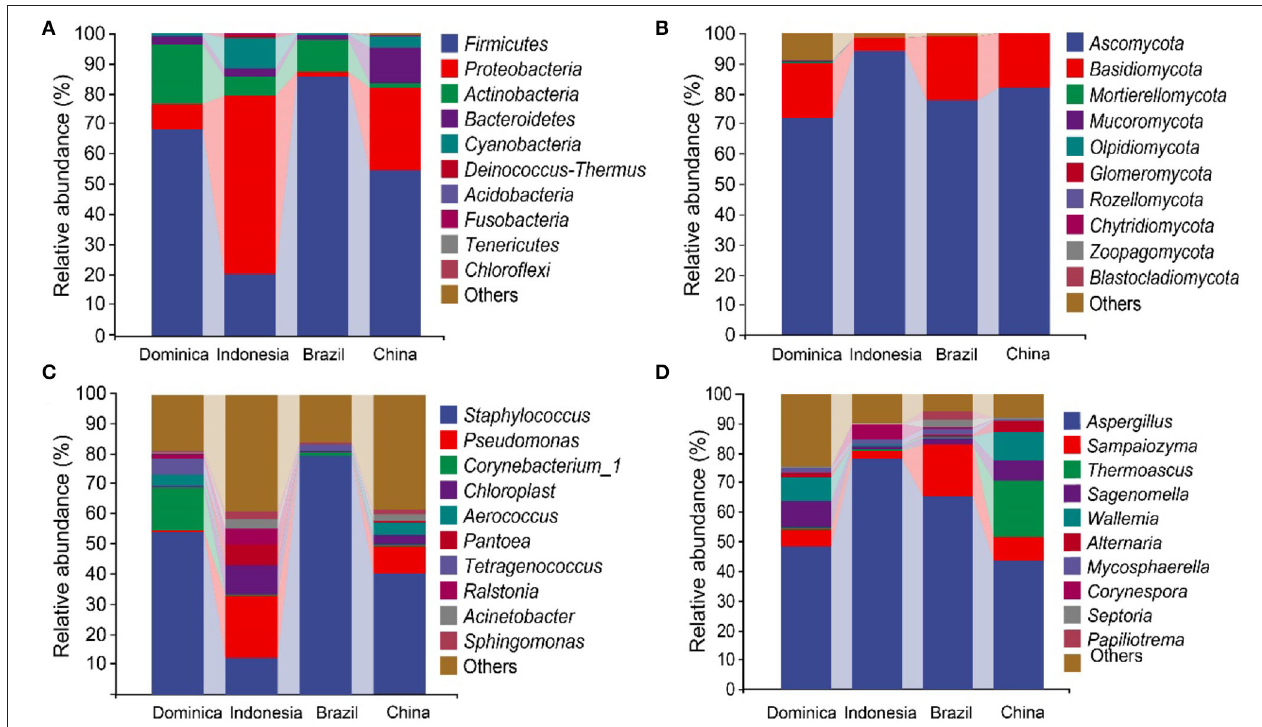
FIGURE 1 | Microbial communities in cigar tobacco leaves. The top 10 predominant bacterial phyla (A) and genera (C) . The top 10 predominant fungal phyla (B) and genera (D) .